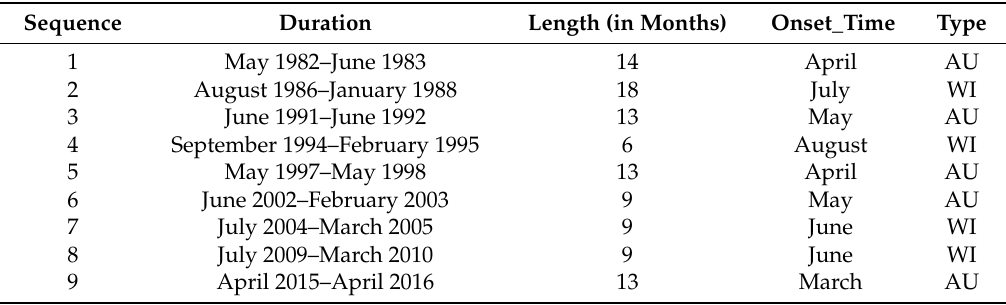
Table 1. Classification of El Niño events during